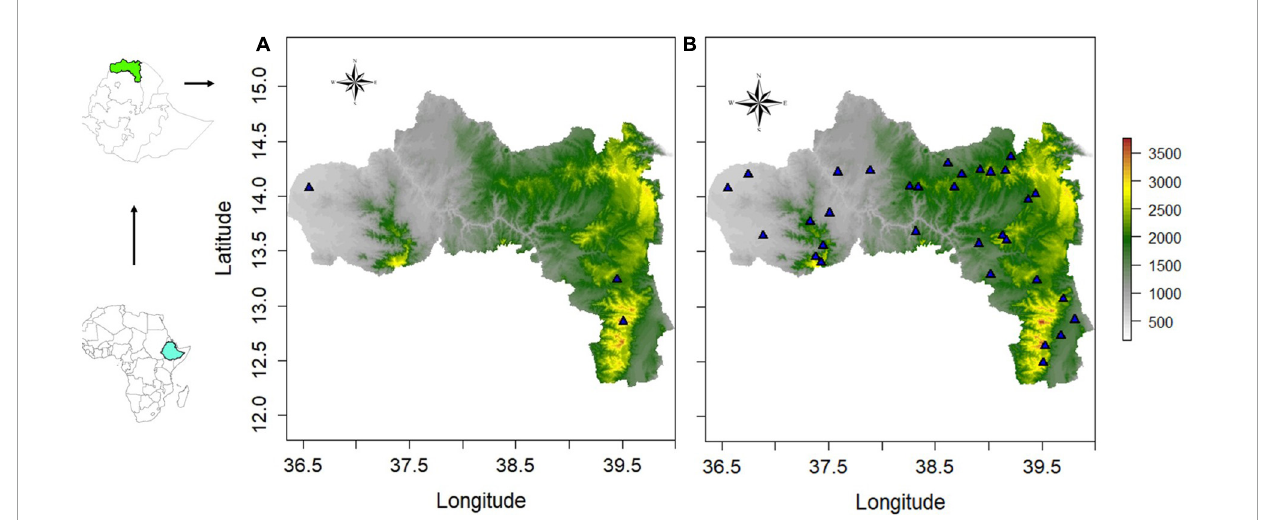
FIGURE1 Sampling sites. (A) Osteological study. (B) Morphological study. See Supplementary Table 1 for the GPS coordinates.